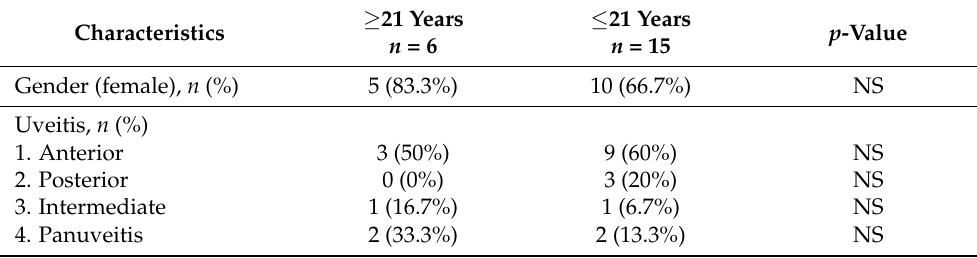
Table 2. Differences in uveitis characteristics of adult and pediatric